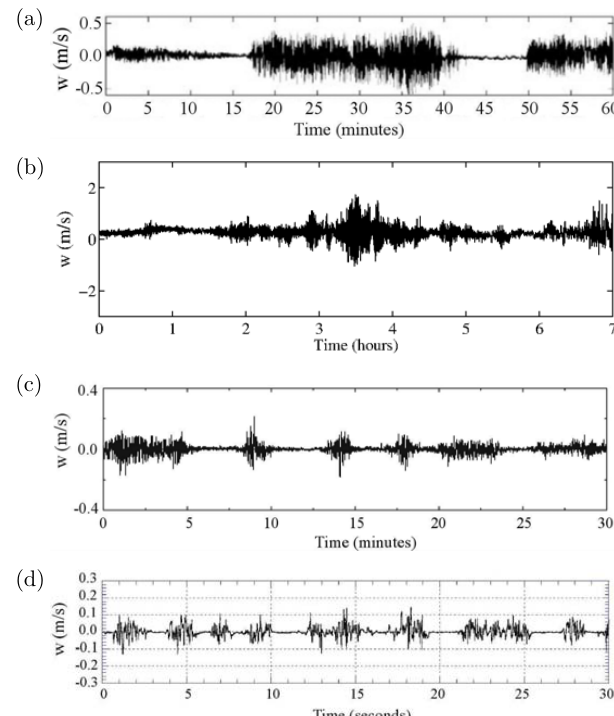
Figure 1. Intermittent time series of vertical velocity observed in field and laboratory experiments. (a) Kansas, USA (Nakamura and Mahrt, 2005). (b) Cabauw, the Netherlands. (c) Summit, Green- land (Cullen et al., 2007). (d) Wind-tunnel experiment (Ohya et al.,